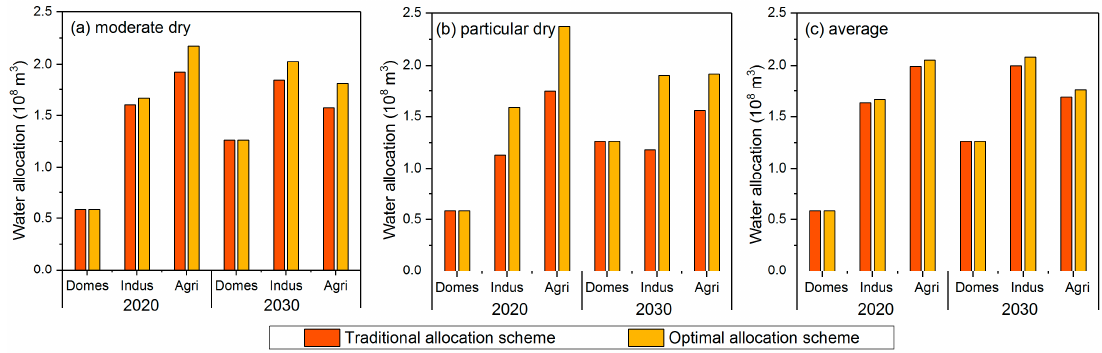
Figure 9. The results of water allocation in both traditional and optimal cases.